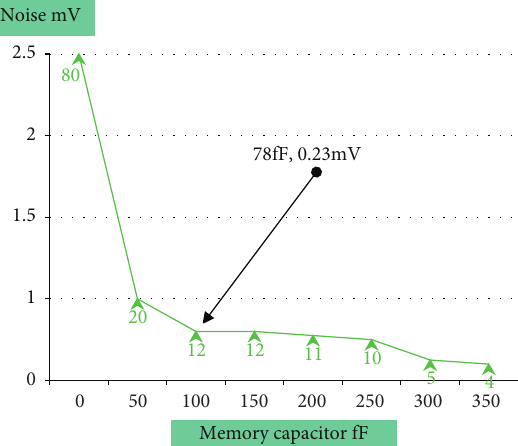
Figure 6: The relationship between kT / C noise and storage capacitor value.